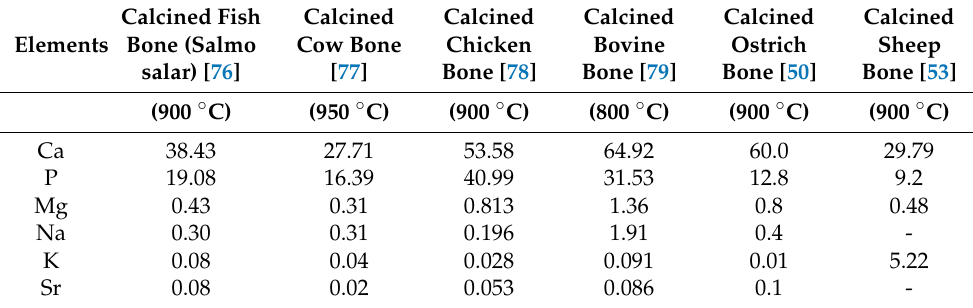
Table 2. Elemental composition of various animal source bone derived catalysts